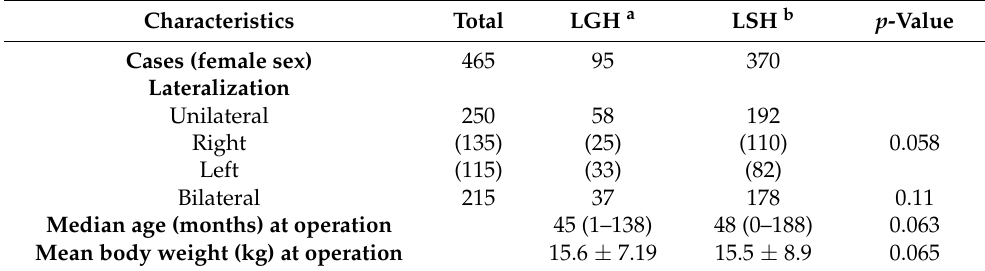
Table 1. Characteristics of patients.